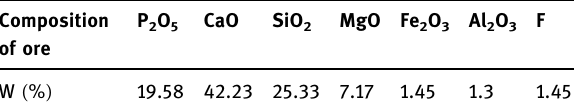
Table 2: Analysis of the industrial coke ( %wt